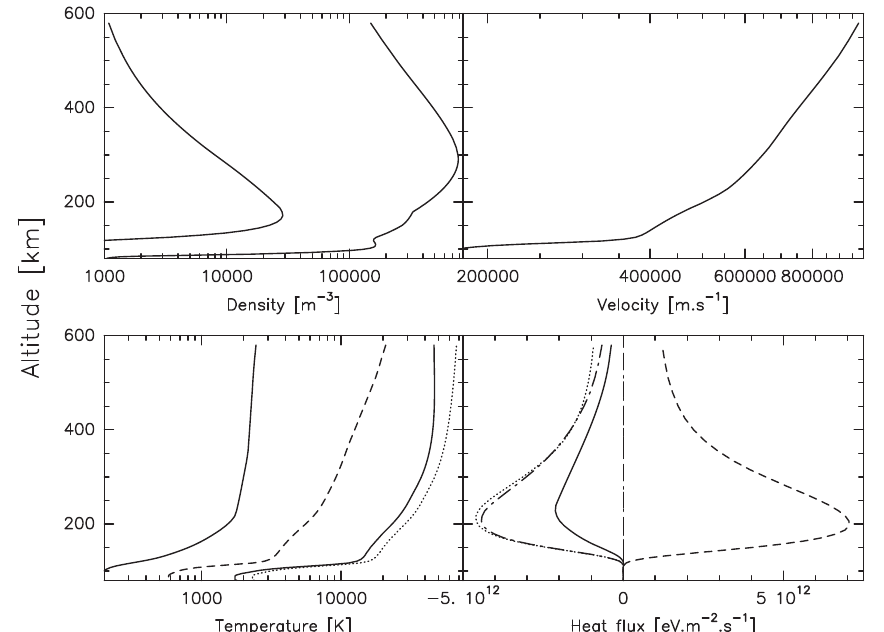
Fig. 5. Suprathermal moments over Algiers during daytime. Upper left panel: from left to right, suprathermal electron density computed in this work, compared to the thermal one provided by IRI (Bilitza et al., 2012). Right panel: suprathermal velocity. Lower left pannel: from left to right, thermal electron temperature provided by IRI, suprathermal electron temperature (dashed line: mean temperature; full line: speci fi c temperature; dotted line: total suprathermal electron temperature). Right panel: suprathermal heat fl ux. With respect to equation (13), we have from left to right: v 2 ( z ) in dotted line, v 5 ( z ) in dot-dashed line, full line v ( z ), along the 0 abscissa are v 3 ( z ) and v 4 ( z ) which are negligible at this scale compared to the other quantities, and fi nally on the right side is v 1 ( z ) in dashed line. The velocity and the heat fl uxes are positive